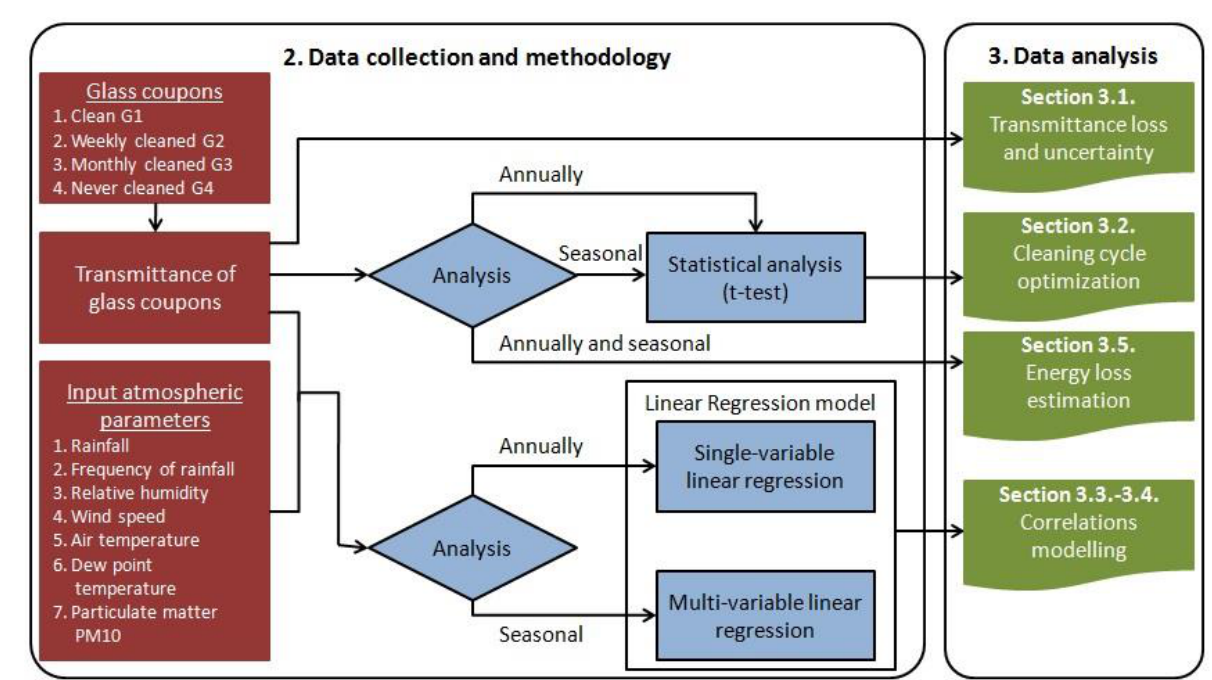
Figure 1. Flowchart of the novel methodology that can (i) evaluate the variability of soiling and its seasonal correlations with environmental factors using the linear regression models and (ii) assess the effectiveness of the different cleaning cycles using the statistical (F- and t -test analysis. The results are presented in the indicated sections.